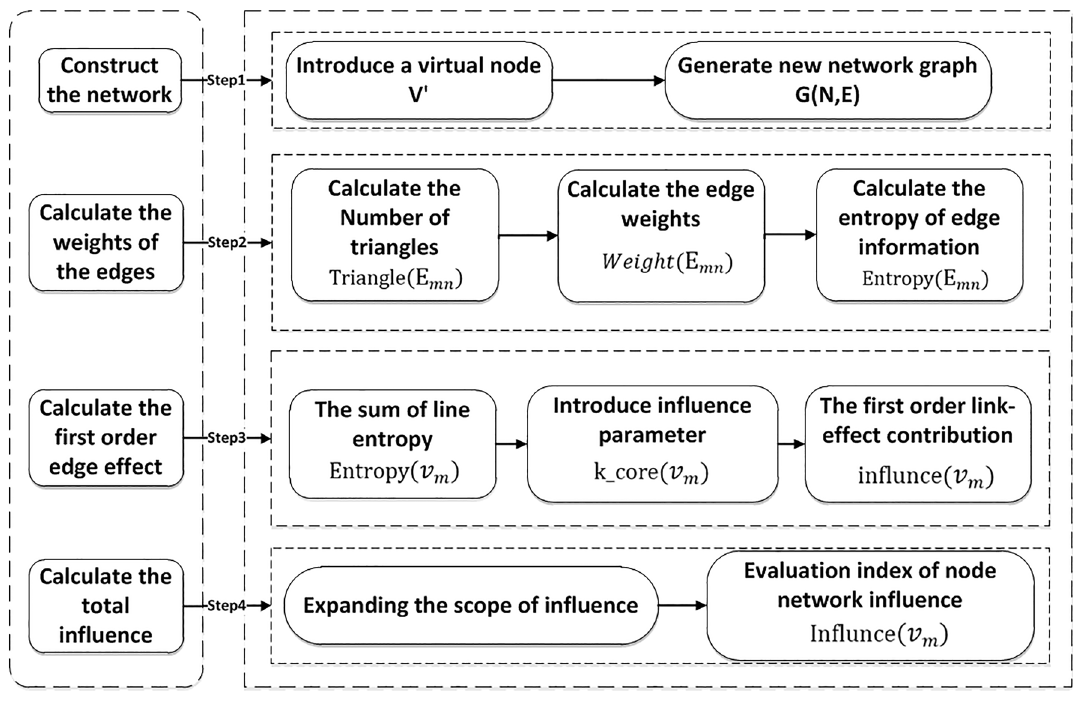
Figure 2. The flow chart of the LENC